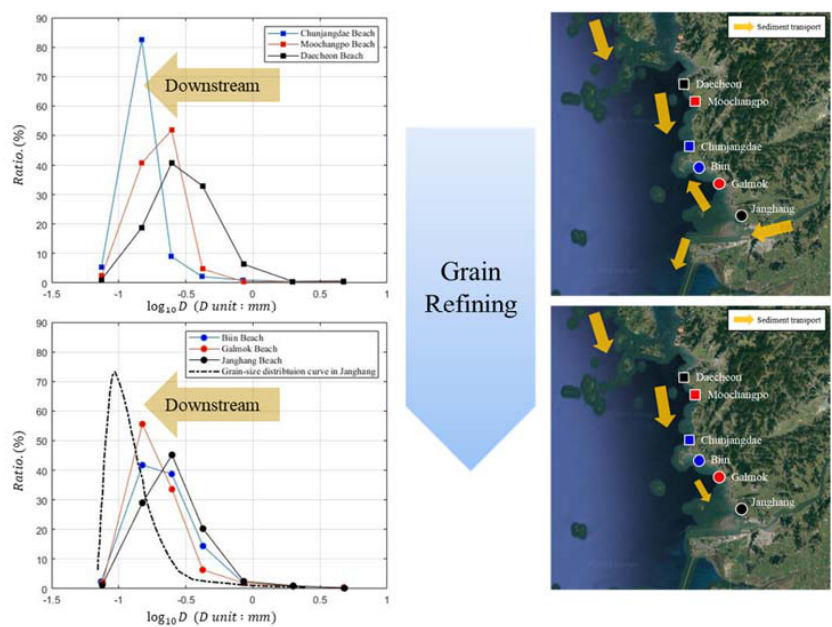
Figure 3. Grain refinement according to change in direction of littoral drift.